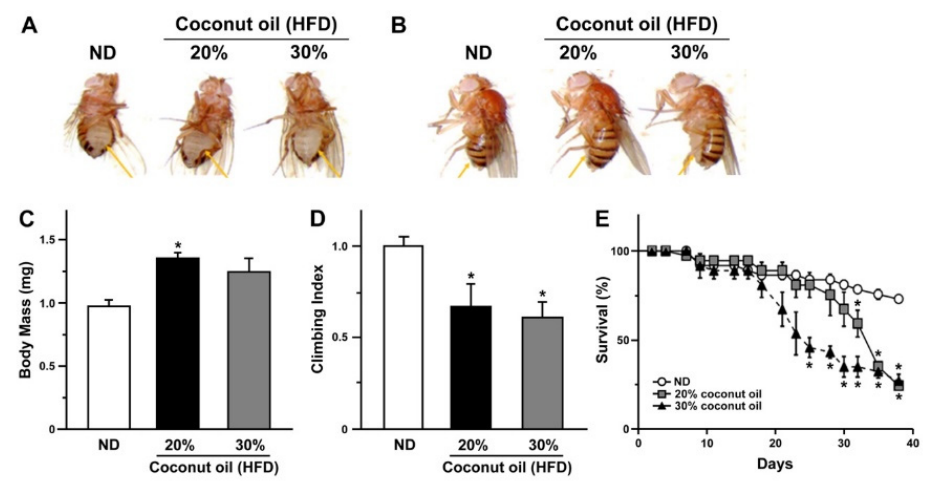
Figure 1. The e ff ects of a high-fat diet on body size, body weight, climbing activity, and life span of adult flies. ( A , B ) The ventral view of flies ( A ) and lateral view of flies ( B ) are shown to compare the di ff erence in body size and morphology between flies fed either with a normal diet (ND) or a high-fat diet (HFD) for 2 weeks ( n = 12 per group).( C , D ) The pooled data on body weight ( C ) and climbing index ( D ) of flies fed either with a normal diet (ND) or a high-fat diet (HFD) for 2 weeks are shown. Mean ± SEM are indicated. *, p < 0.05. ( E ) The life span of flies is shown for each rearing condition indicated ( n = 12 per group). Mean ± SEM are indicated for experiments repeated three times. *, p < 0.05.